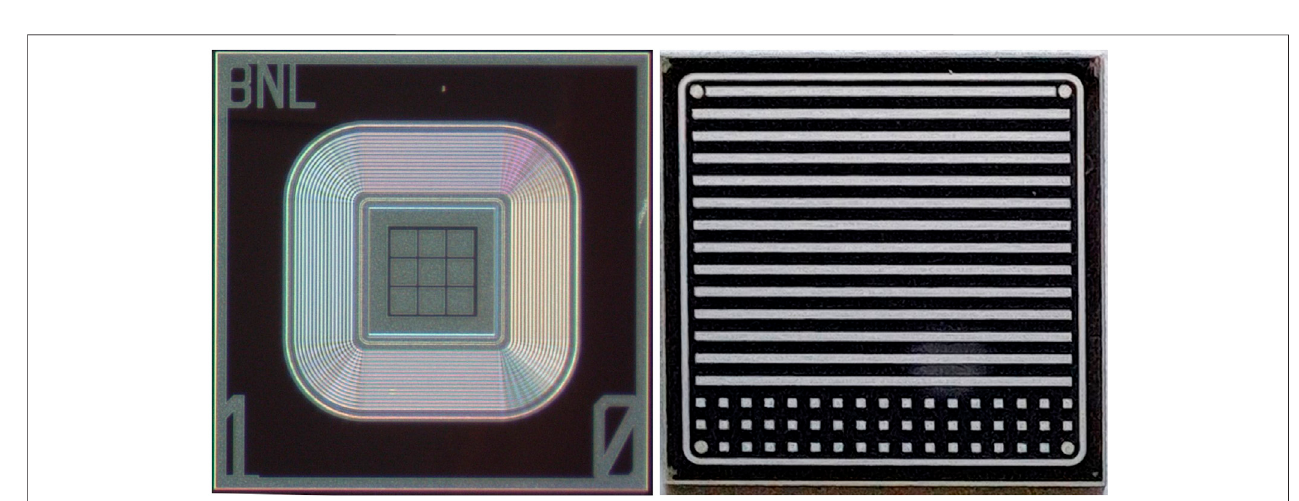
FIGURE 11 | Picture of AC-LGADs, coming from two different foundries: left, BNL and, right, CNM.